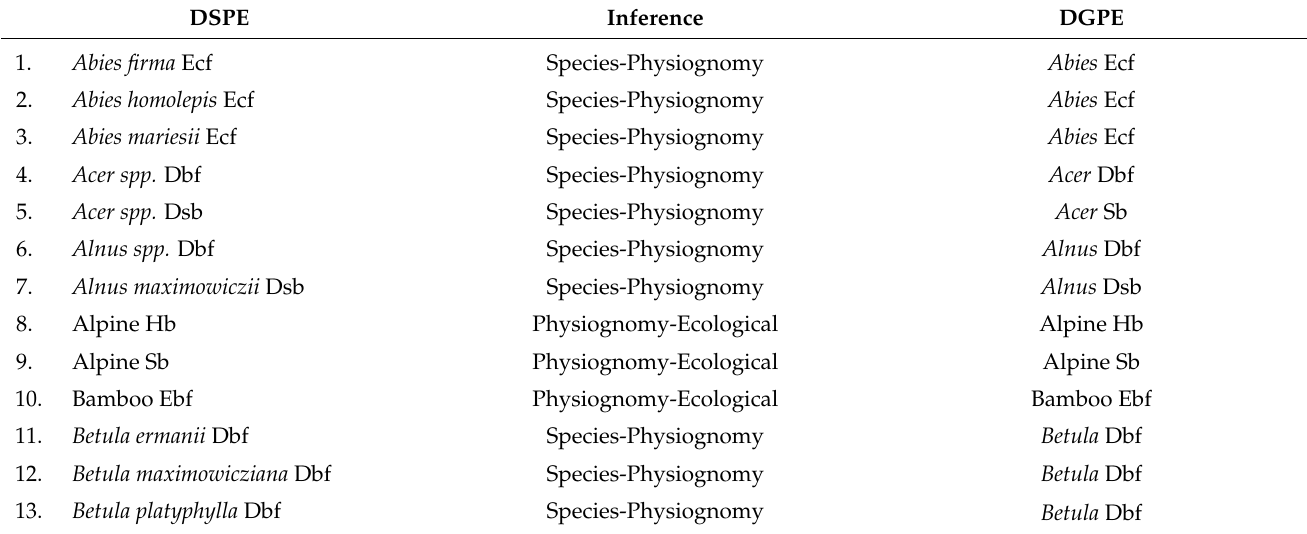
Table 1. List of DSPE communities of the study area and the inferences used for defining